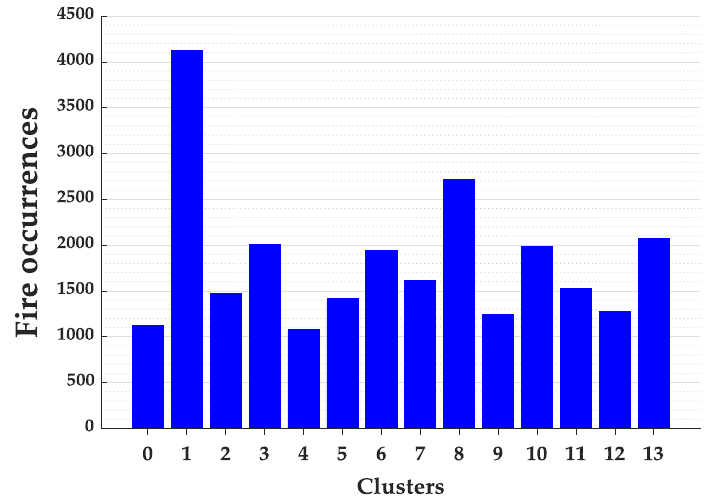
Figure 4. Fire occurrences for each cluster of the Maranhão State.